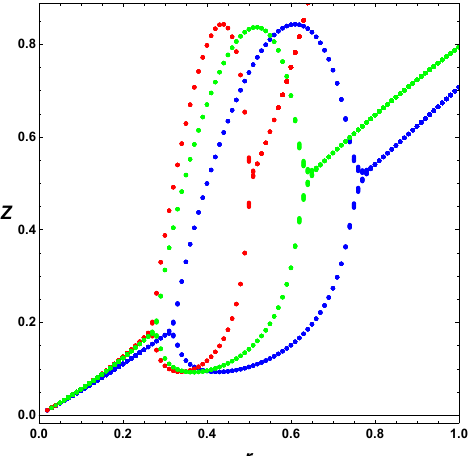
Figure 9. Poincare section of extrema, with k d = 1, k u = 0.01, K = 0.50 and φ = 1. Red implies constant input; blue implies m = 1; and green implies m =